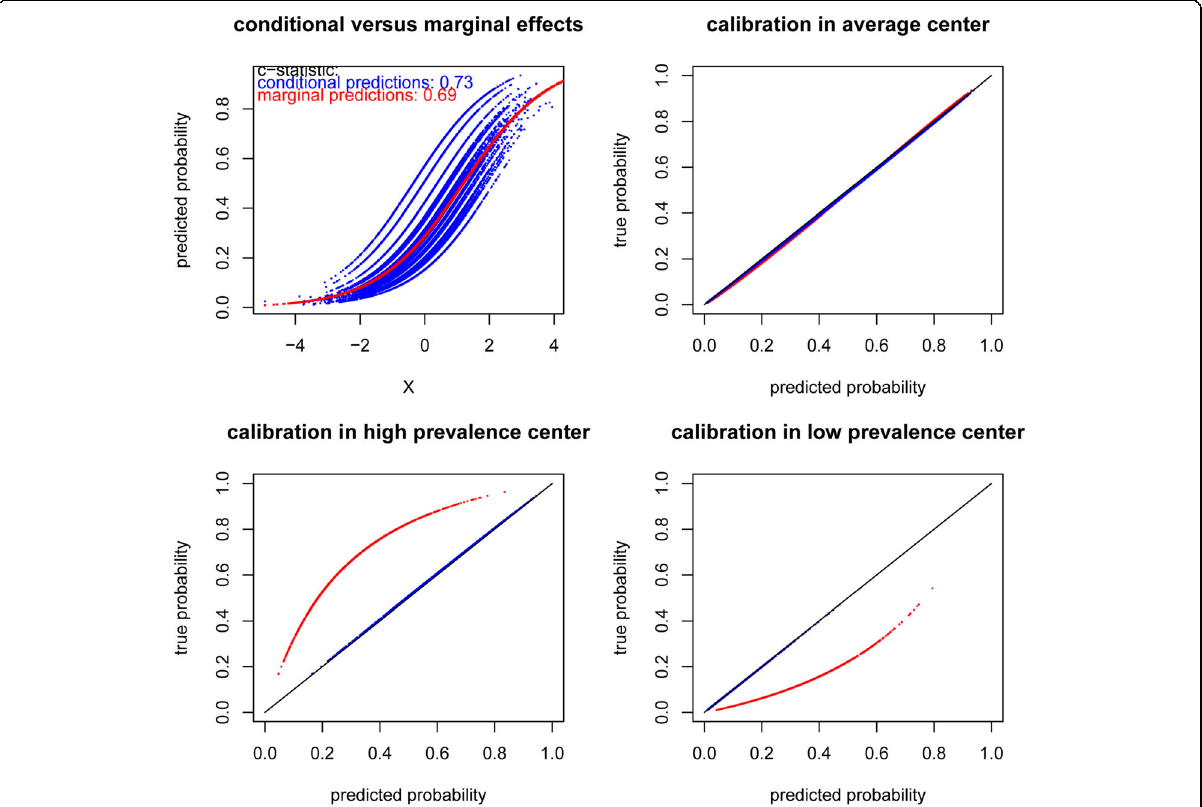
Fig. 7 Didactical example of predictions made ignoring center effects, when differences between centers are